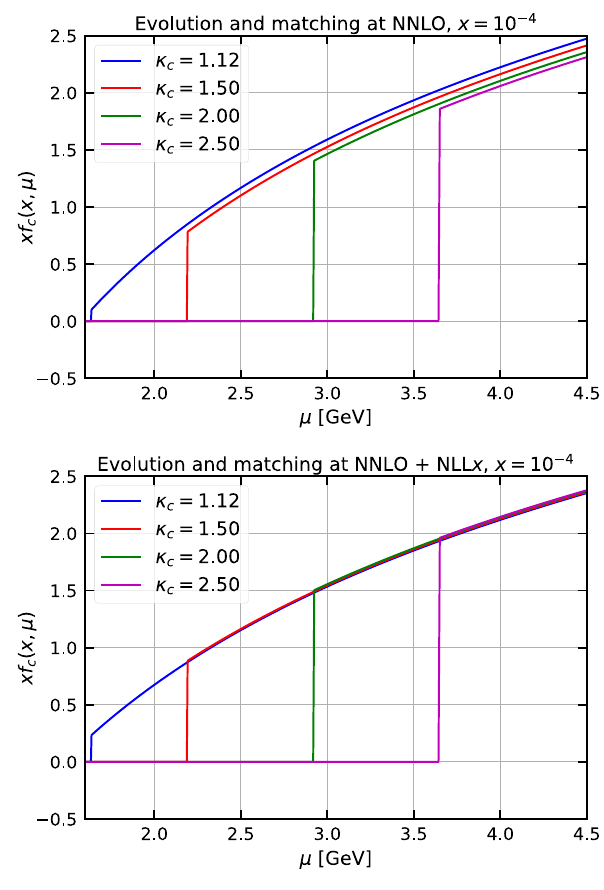
Fig. 2 The charm PDF at x = 10 − 4 as a function of the factorisation scale μ for different values of the charm-quark matching scale μ c = κ κ = 1 . 12 , 1 . 5 , 2 , 2 . 5. The plots show the effect of the c m c , with c matching at NNLO (upper plot) and at NNLO+NLL x (lower